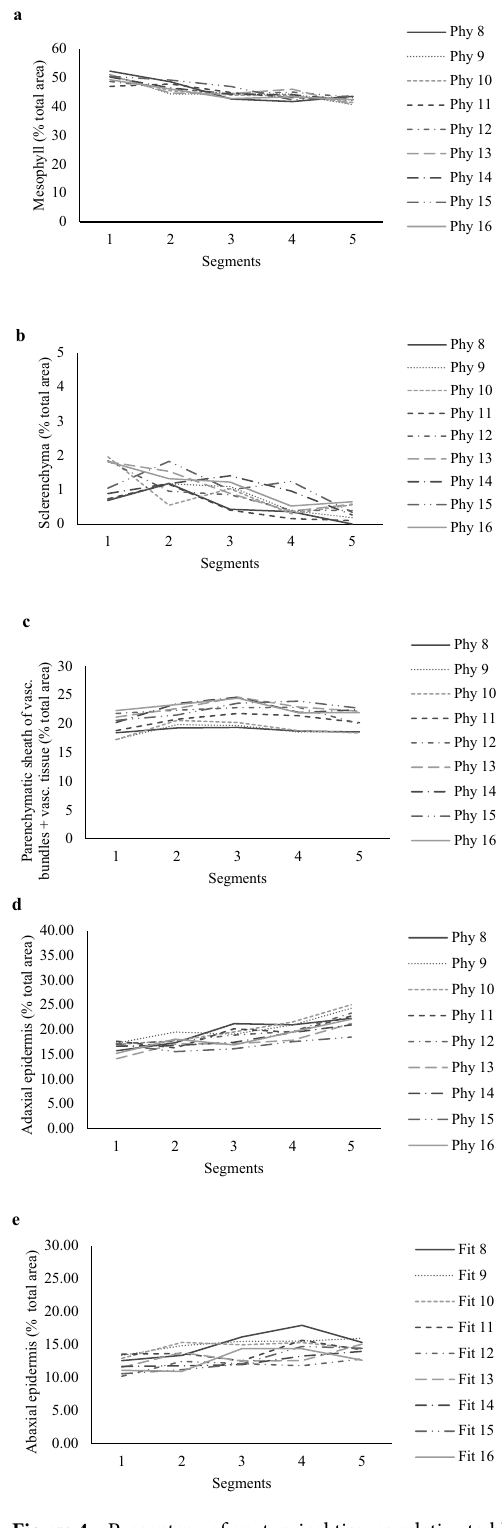
Figure 4. Percentage of anatomical tissues relative to blade total cross-section area of leaves with contrasting levels of insertion on the tiller axis (phytomers) of Napier elephant grass. ( a – e ): mesophyll, sclerenchyma, parenchymatic sheath of vascular bundles + vascular tissue, adaxial and abaxial epidermis, respectively. Phytomers were all harvested after complete expansion of leaf